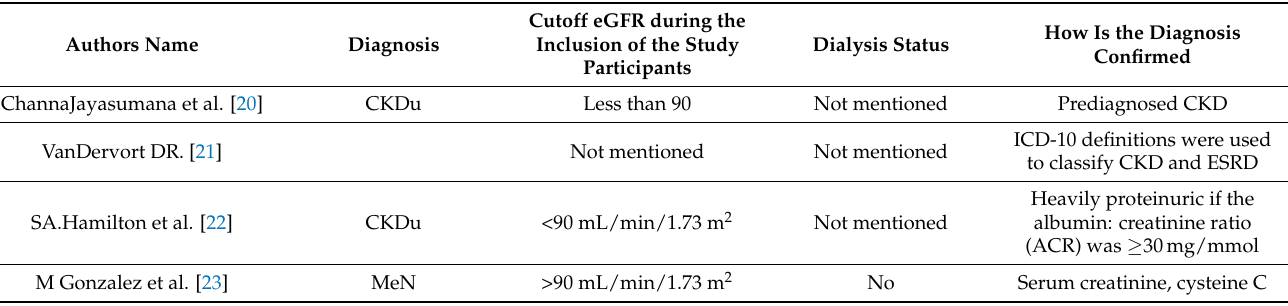
Table 3. Diagnosis and dialysis status of study